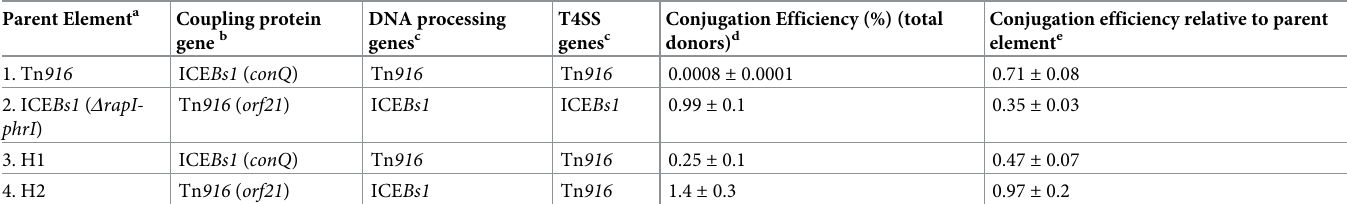
Table 2. Coupling proteins can recognize non-cognate